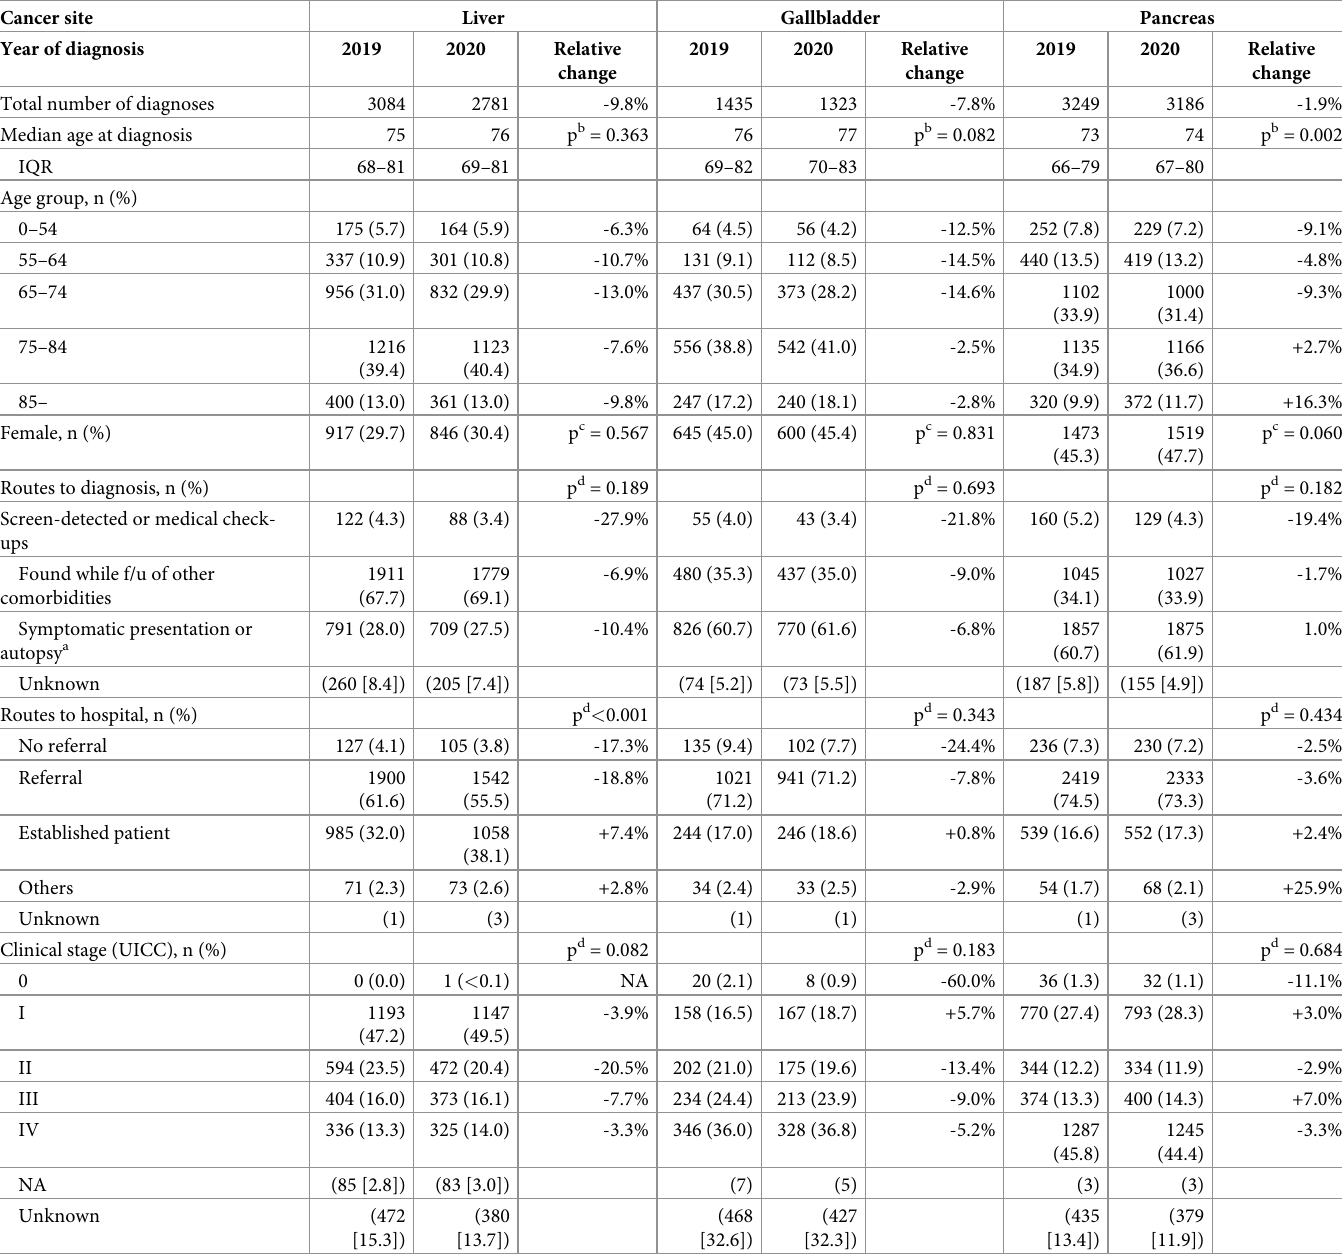
Table 2. Baseline characteristics of patients diagnosed with six digestive cancers in the CanReCO